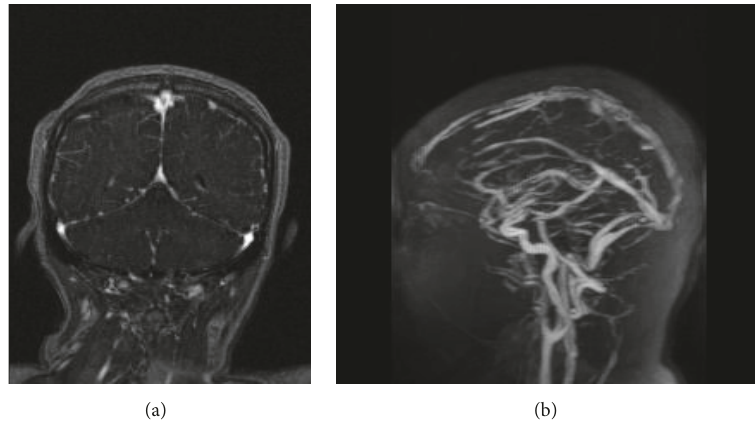
Figure 3: Follow-up MRV of the head 5 months after diagnosis noted minimal residual thrombus in the superior sagittal sinus (a), with resolution of the thrombus in the right sigmoid, and transverse sinuses